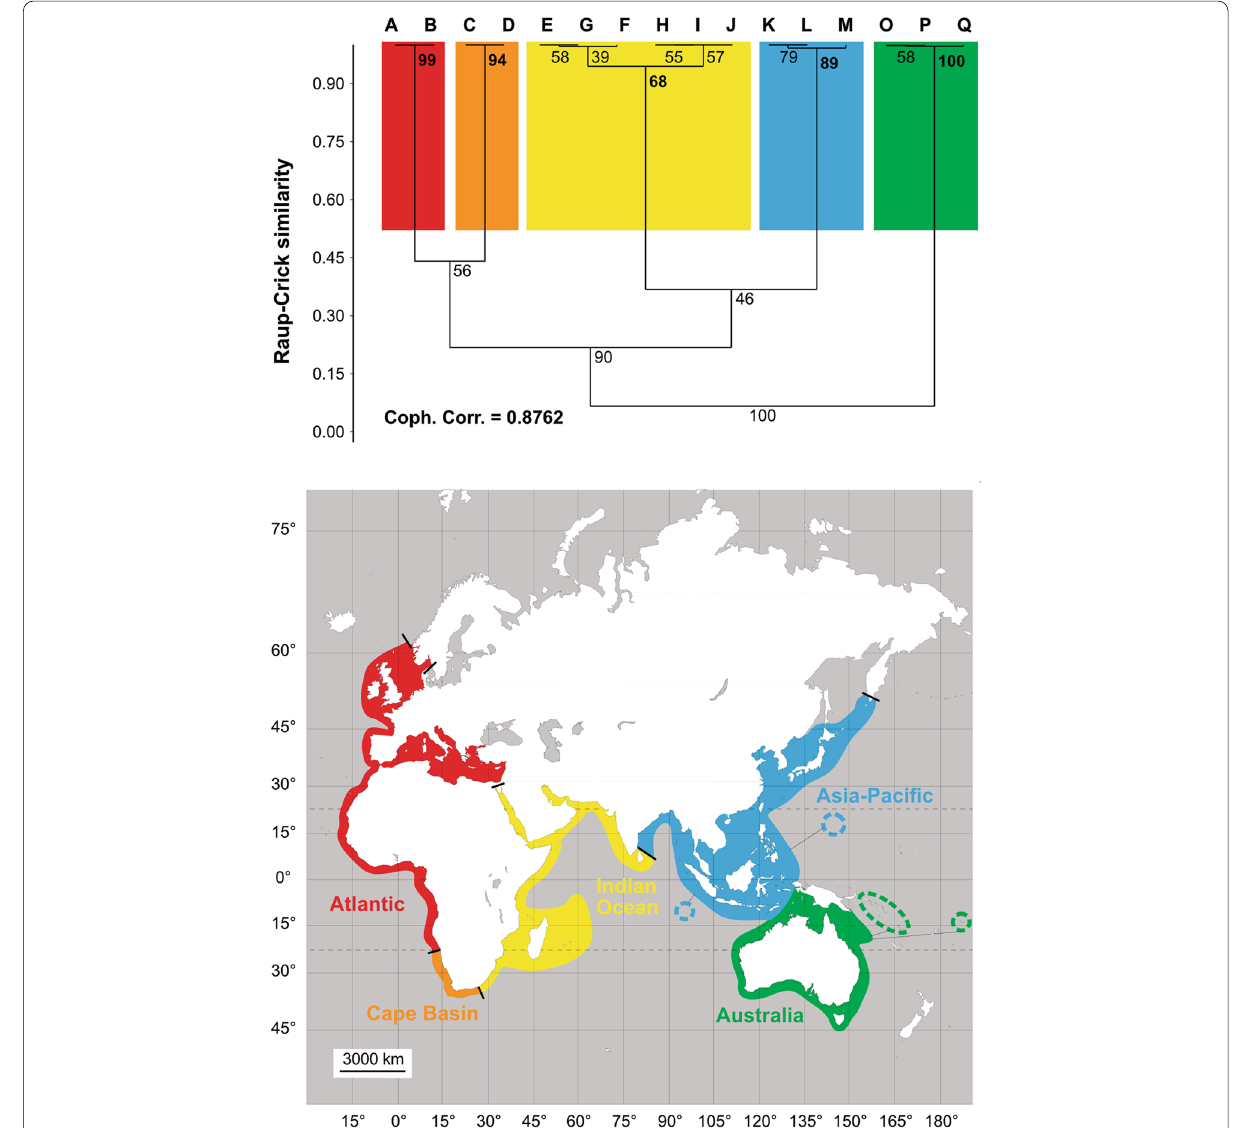
Fig. 6 Top: similarity analysis of cuttlefish assemblages represented by cluster dendrograms with bootstrap values for each node (see text). Colors reveal the main biogeographical clusters: Atlantic, Cape Basin, Indian Ocean, Asia-Pacific, Australia. Bottom: world divided into the five biogeographic clusters according to the similarity